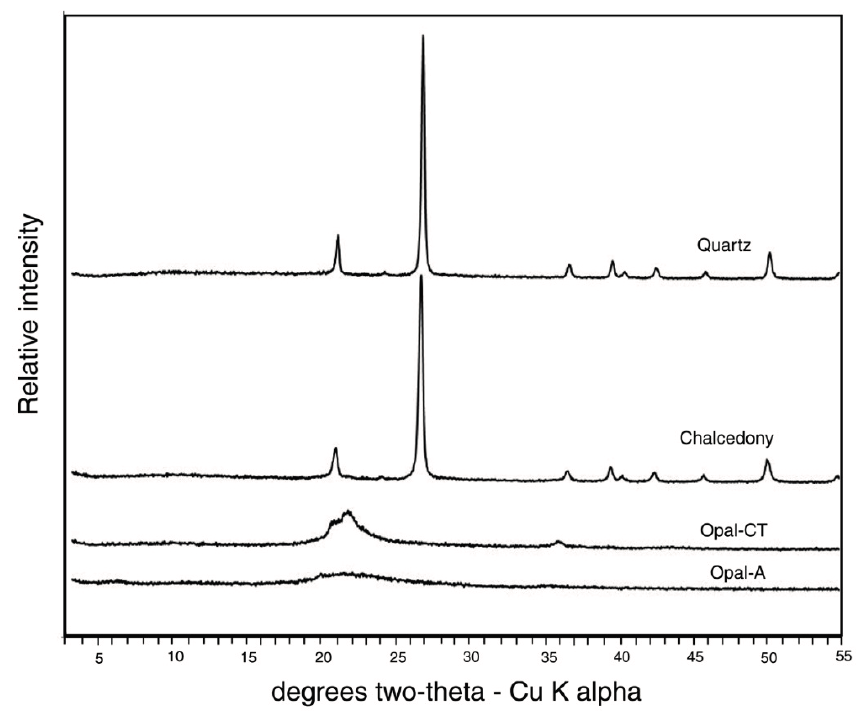
Figure 4. X-ray diffraction patters of silica polymorphs in silicified